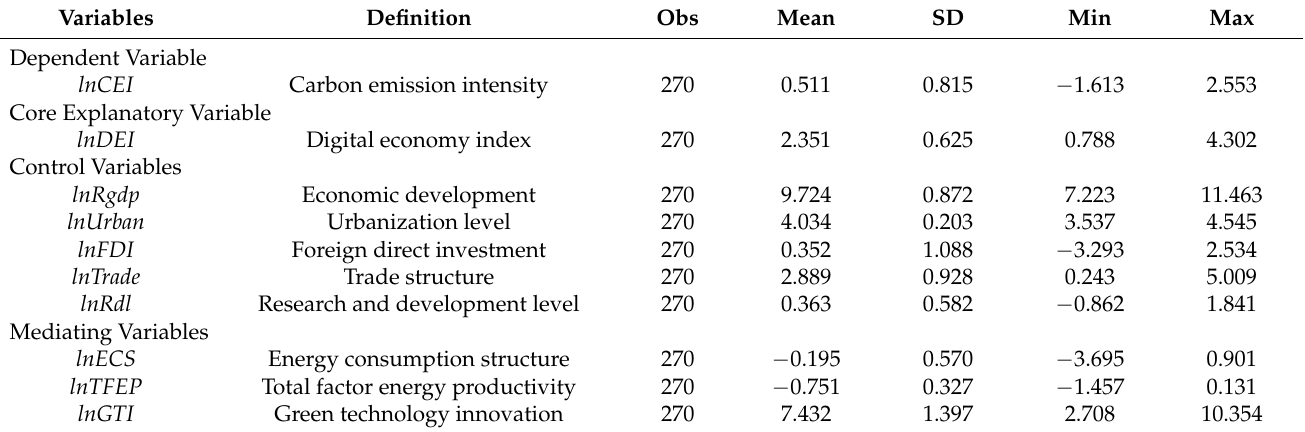
Table 4. Descriptive statistics of the